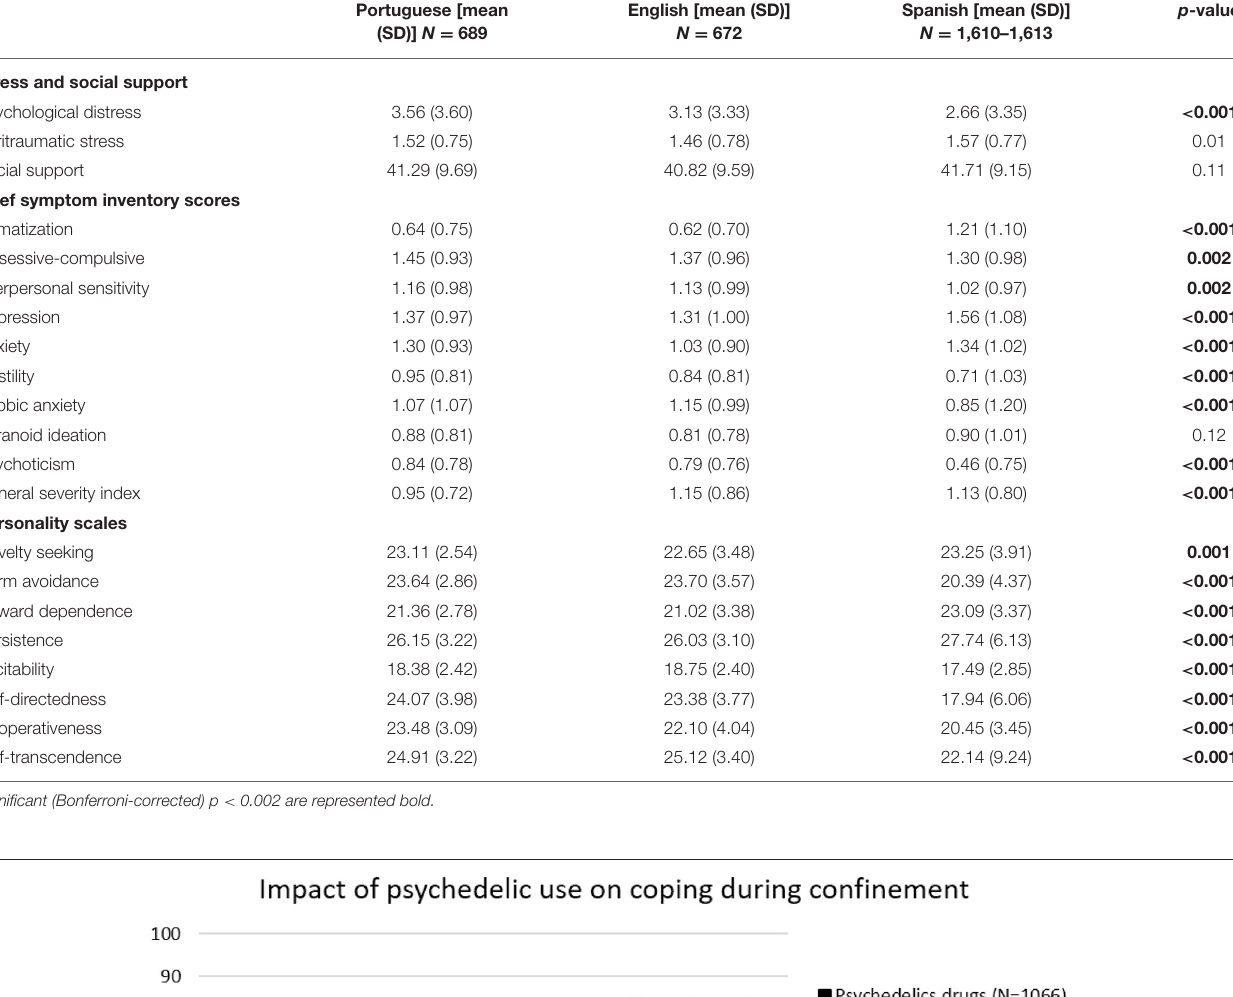
Portuguese [mean (SD)] N = 689